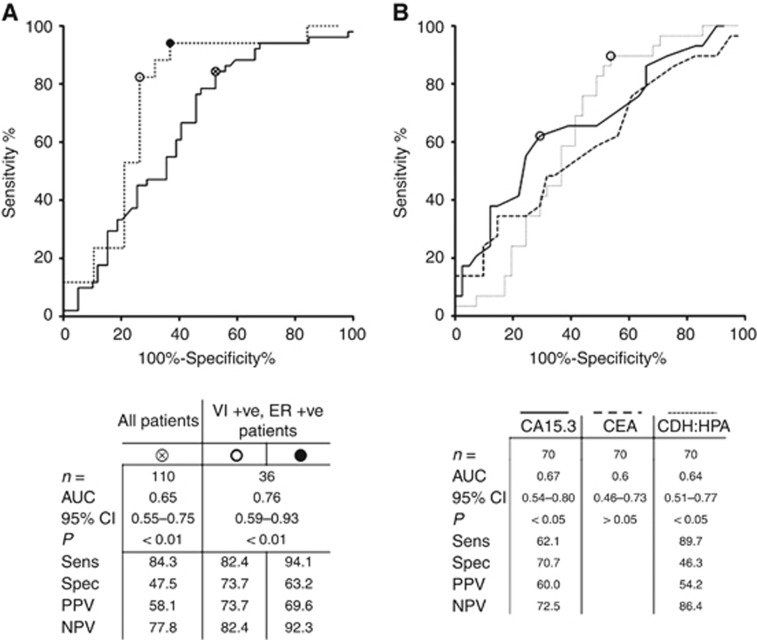
ROC curves plotted to calculate sensitivity, specificity, PPV and NPV. (A) CDH5:HPA ratio for all patients (solid line) and for vascular invasion positive, ER-positive patients (broken line). (B) Comparison of CA15.3, CEA and CDH:HPA.